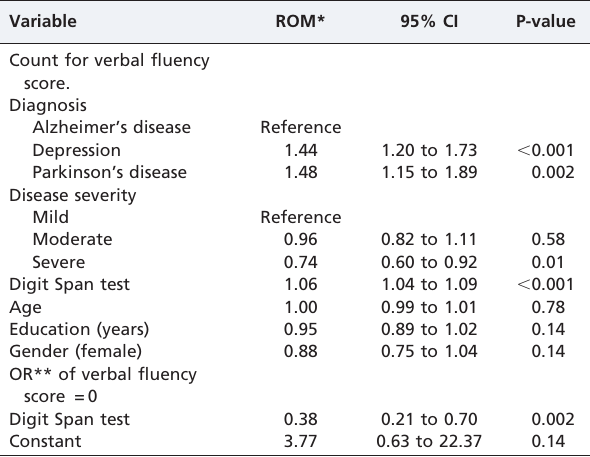
Table 1 - Demographic and clinical characteristics of the patients (n= 103). Characteristics